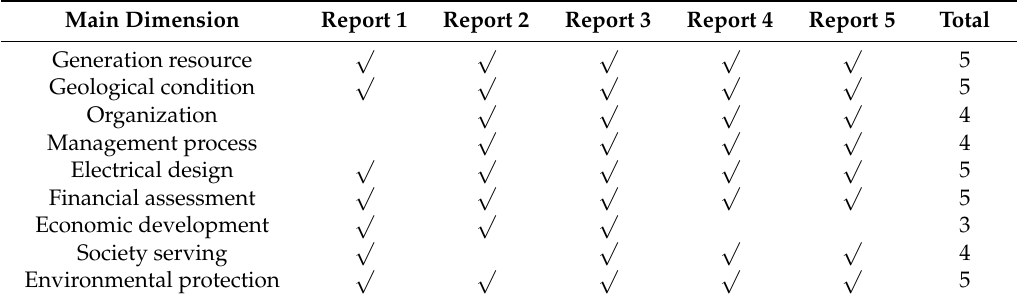
Table 2. Evaluation index summary on feasibility reports of distributed PV-generation